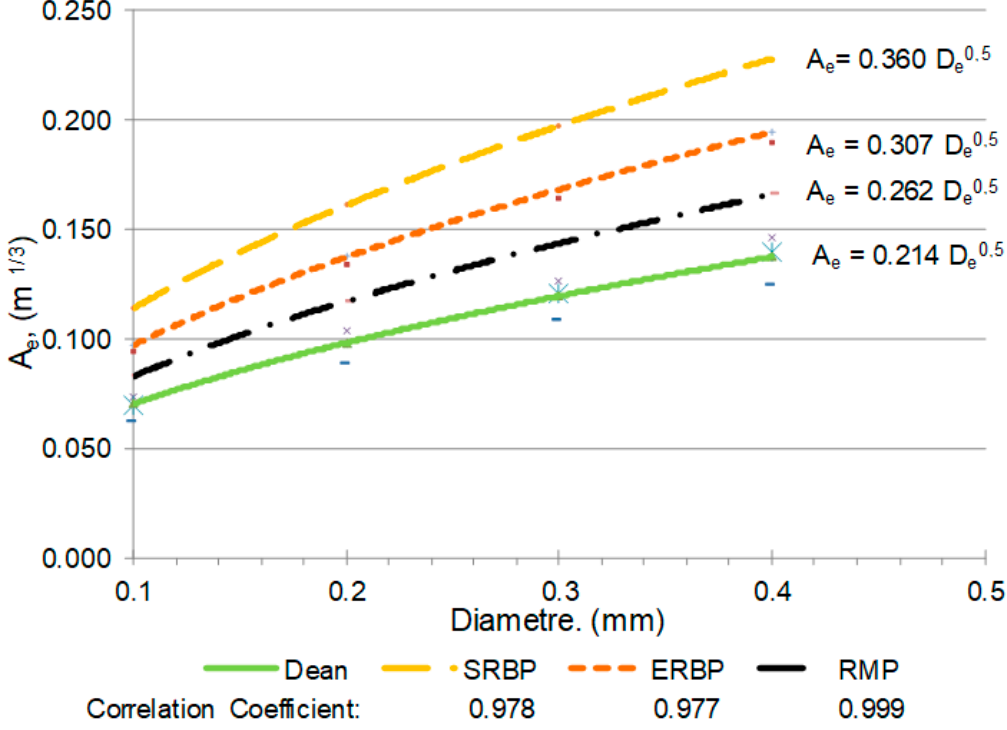
Figure 6. Relationship between the shape parameter of the emerged parabola vs. the average emerged diameter for the three different types of profile (ERBP, SRBP, and RMP). Comparison with Dean’s formula.